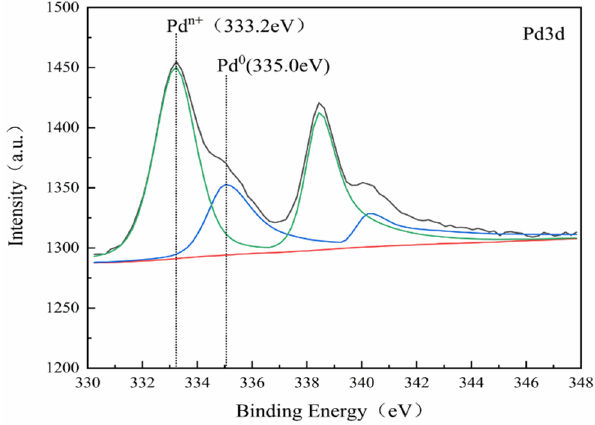
Figure 6. XPS spectra of the Pd 3d peaks of PN-1:1.